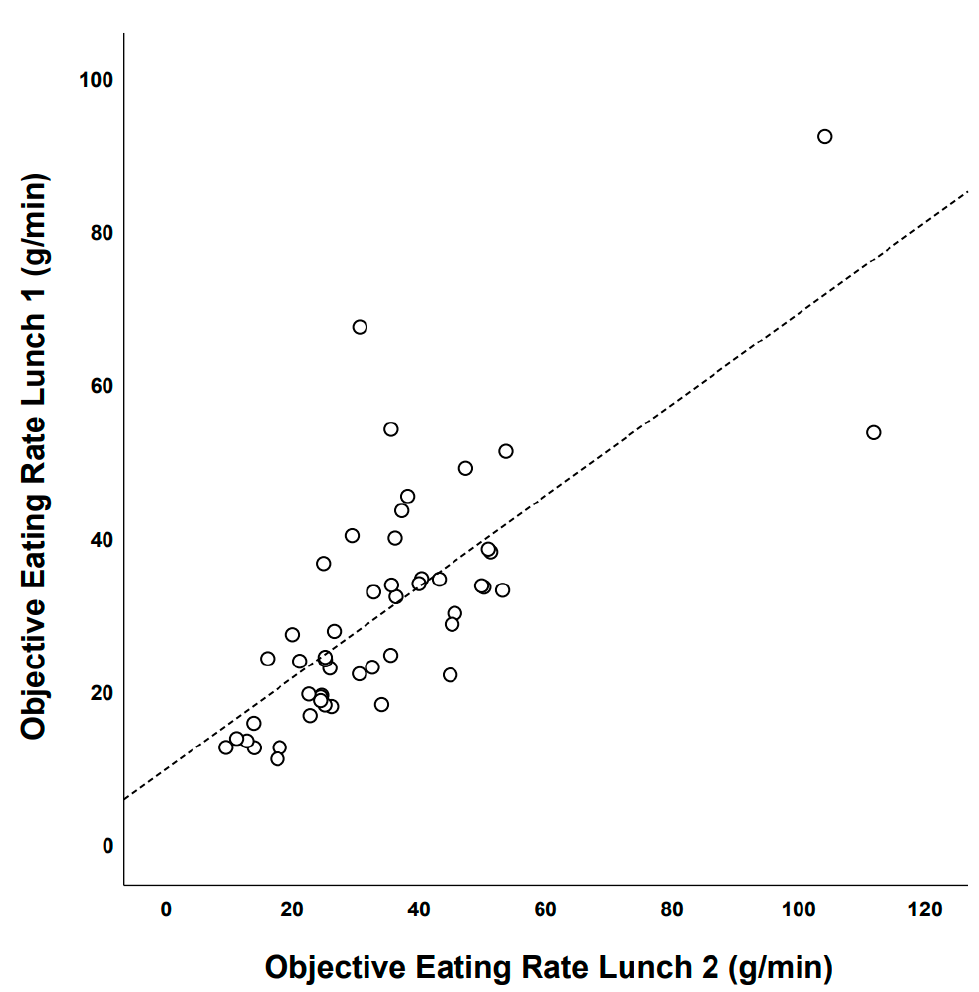
Figure 7. Objectively measured eating rate lunch 1 vs. objectively measured eating rate lunch 2 among IEGS students who ate repeated school lunches (Lunch 1: December 2015 and, lunch 2: February/March 2016).